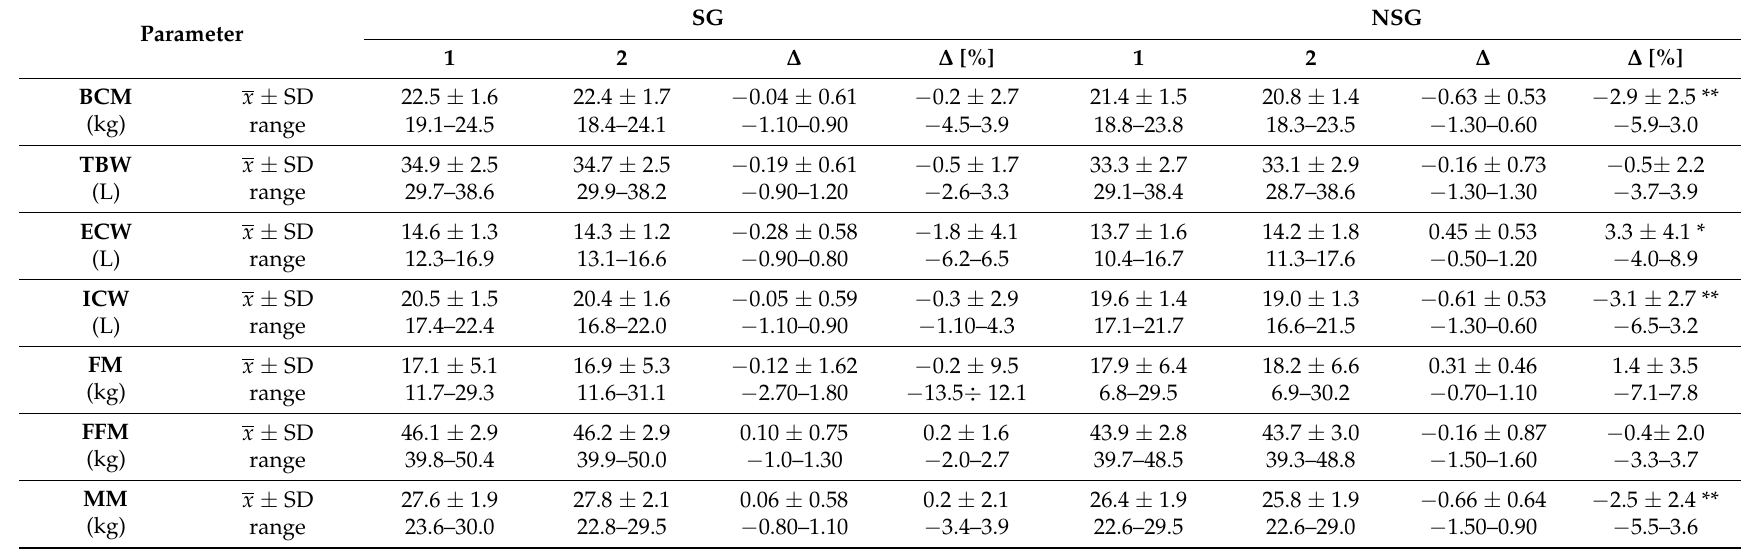
Table 2. Rest values of body compositions parameters in the examined groups: SG (swimming group) and NSG (non-swimming group); rest values pre (1) and post (2) 12-week swimming training. The values are given as mean ± SD, ∆ %—percentage